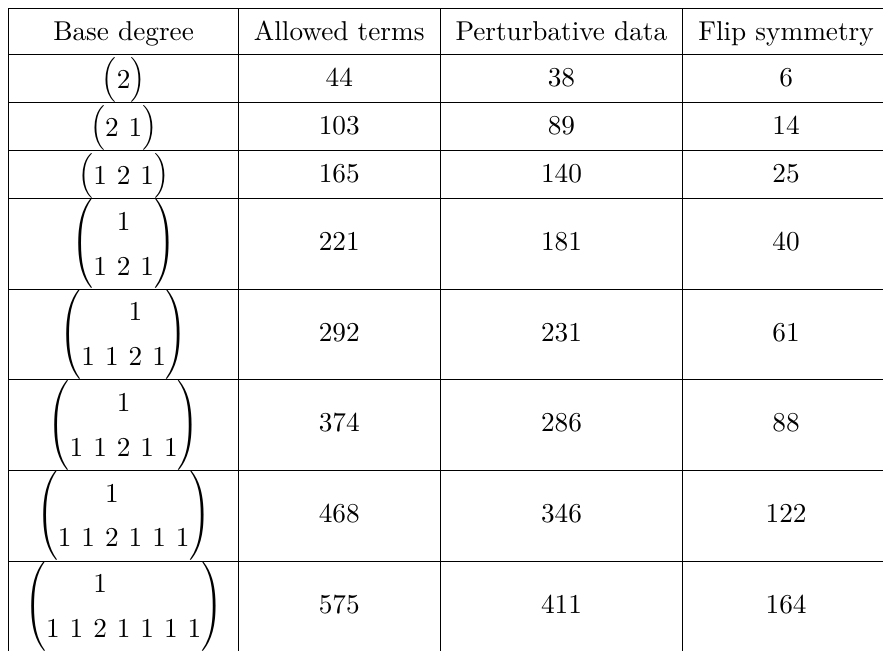
The ‘allowed terms’ column denotes the number of solutions of the modular con- straints (3.5). The ‘perturbative data’ column denotes the number of the terms whose coefficients can be fixed by the perturbative data using (3.12). The ‘flip symmetry’ column denotes the number of the terms whose coefficients can be further fixed by the flip symmetry using